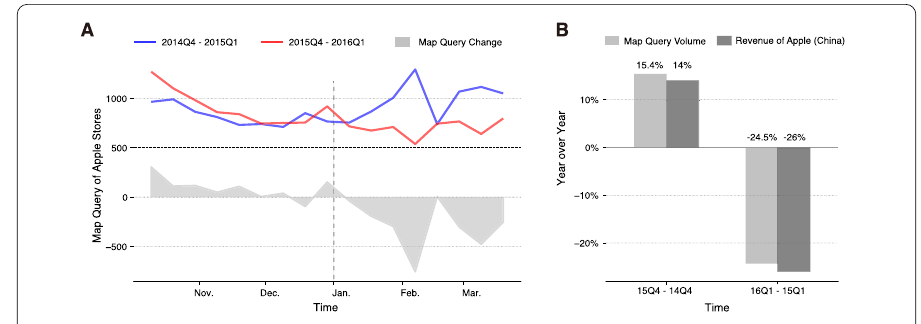
Figure 7 Map queries for Apple Stores and revenues. (A) The volume of map queries for flagship Apple Stores in Mainland China. Year-over-year changes in queries are plotted as grey areas. (B) The volume of